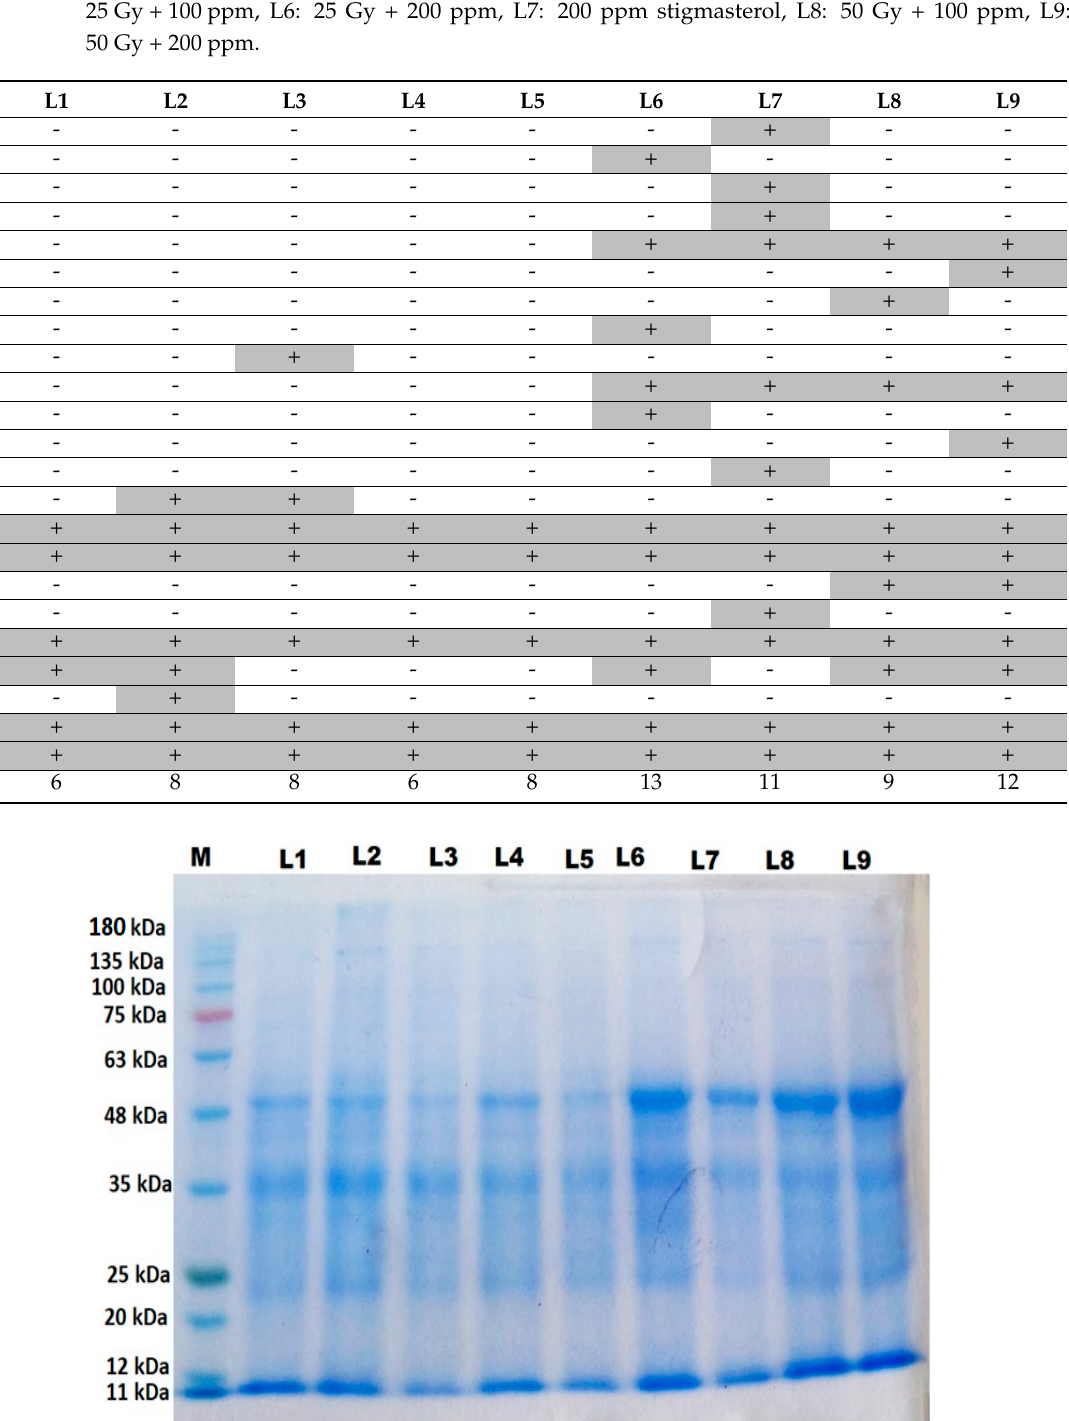
Table 2. Changes in protein profile in leaves of wheat plants originated from irradiated grains and treated with stigmasterol. L1: Control, L2: 25 Gy, L3: 50 Gy, L4: 100 ppm stigmasterol, L5: